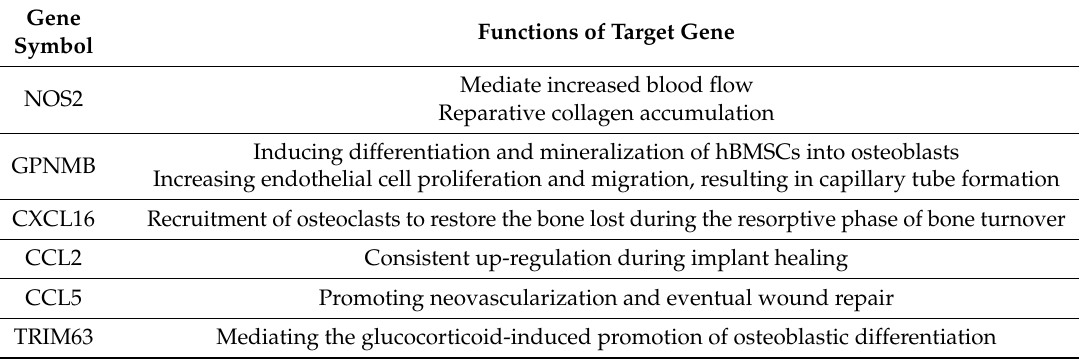
Table 3. Target genes related to tissue healing or bone regeneration.